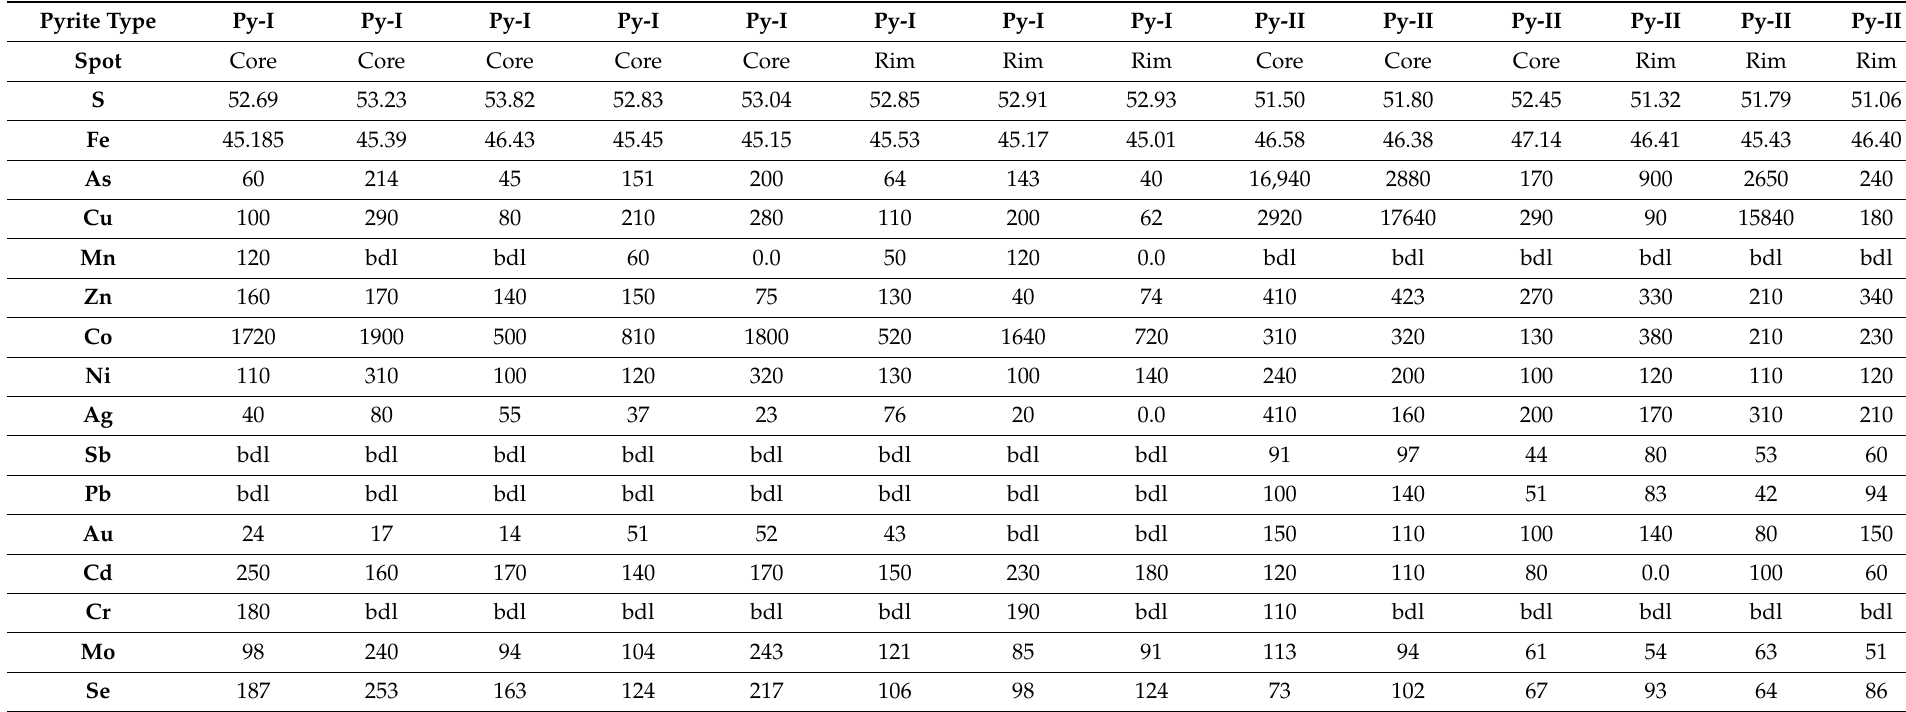
Table 2. EPMA analysis of pyrite from the Kargah Cu-Pb polymetallic deposit. Major elements (S and Fe) are in wt.%, while the rest of the elements are presented in ppm. bdl, below the detection